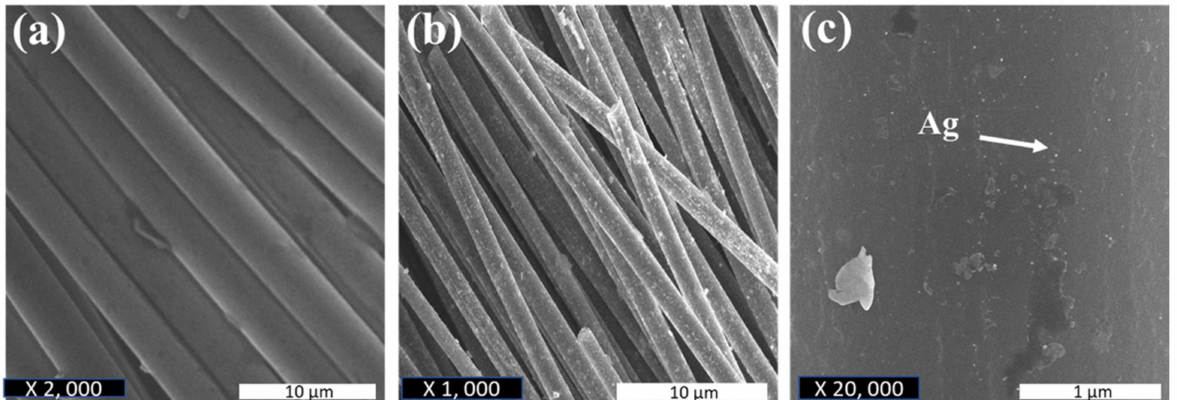
Figure 7. ( a ) Surface morphology of ACF sheet; ( b ) Surface morphology of ACF sheet loaded with synthesized Ag NPs-PTA; ( c ) corresponding magnified image of ACF containing dispersed Ag